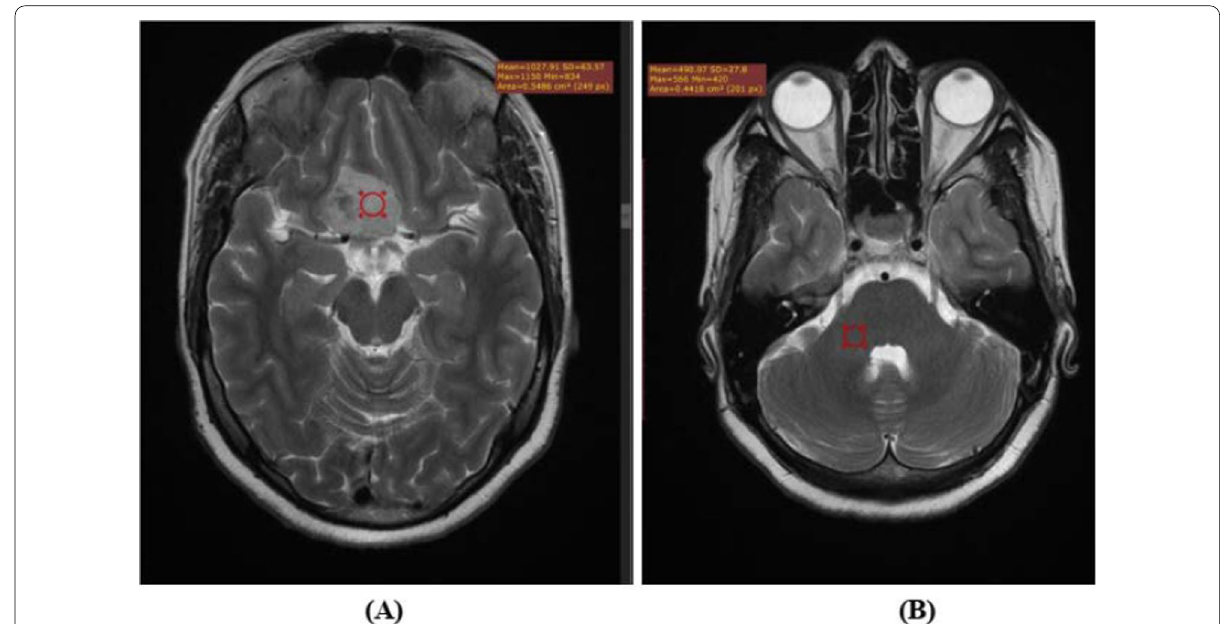
Fig. 2 MRI of soft Tuberculum sellae meningioma. A , B Axial T2-weighted MR images at the level of Tuberculum sellae meningioma and at the level of middle cerebellar peduncles showing TCTI ratio of 2.2, proved surgically to have soft